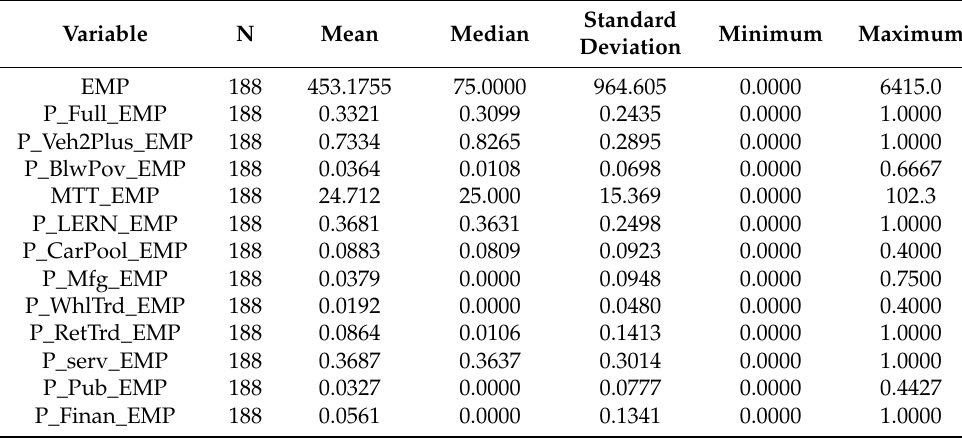
Table 7. Descriptive Statistics for Group B